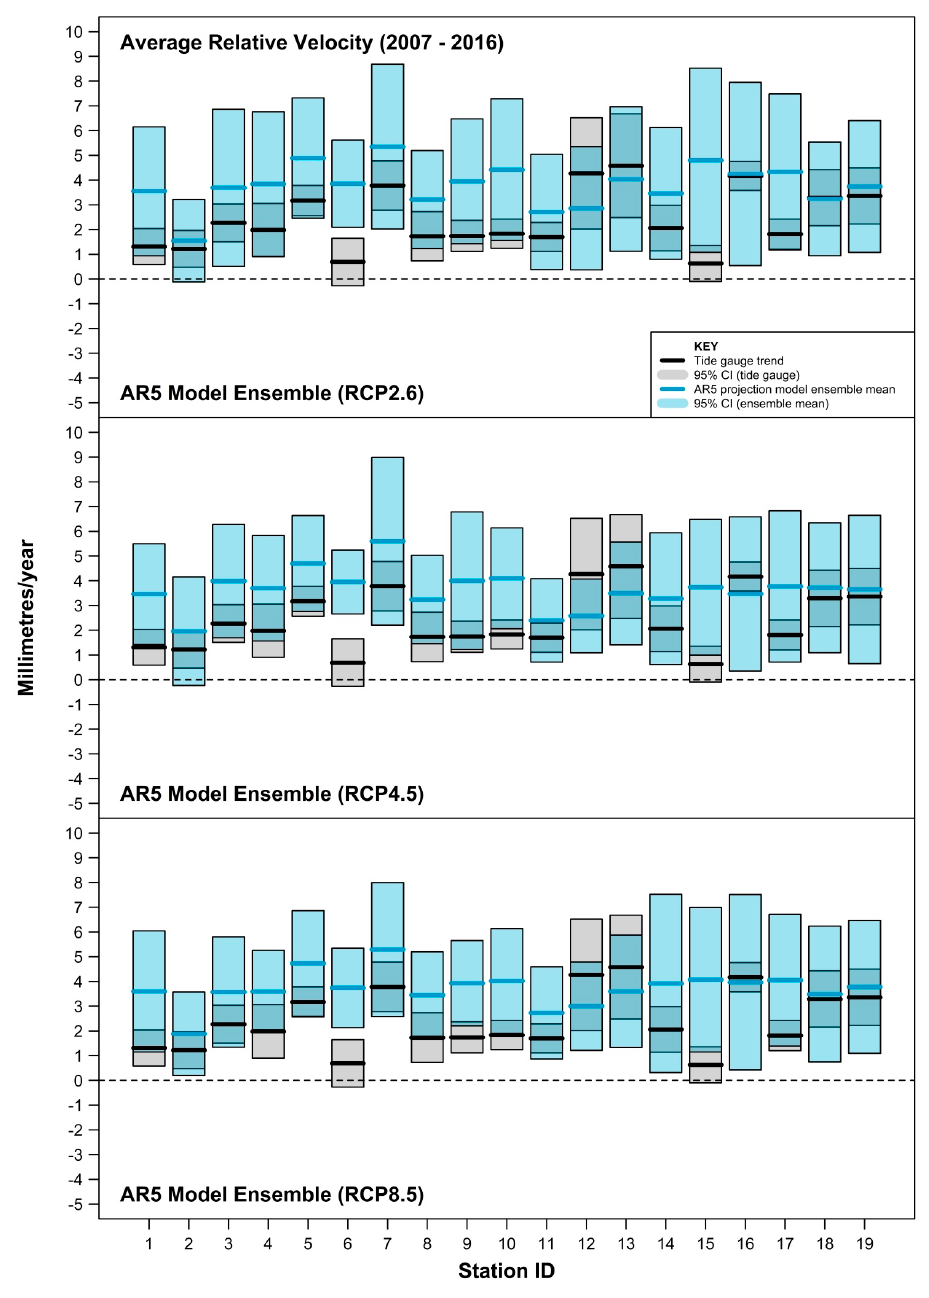
Figure 3. Average “relative” velocity determined over the period of common coverage (2007–2016). These charts directly compare the observational record (tide-gauge analysis) and corresponding AR5 ensemble-model projections at the grid point of interest. Refer to Figure 1 and Table 1 for station ID details.